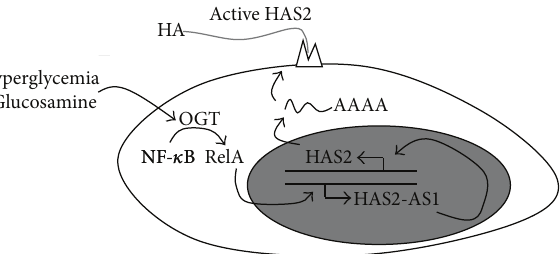
Figure 4: Schematic representation of the regulation of HAS2 expression by OGT in SMCs. In normal conditions, basal HAS2 and HAS2-AS1 expression are allowed. After the induction of O- GlcNAcylation (due to hyperglycemia or after glucosamine treat- ments), the NF- 𝜅 B subunit RelA can be modified with O-GlcNAc by OGT. In the cell nucleus, glycosylated RelA can activate HAS2- AS1 transcription, which, in turn, changes chromatin structure around the HAS2 promoter (probably altering chromatin signature) favoring HAS2 expression leading to HA